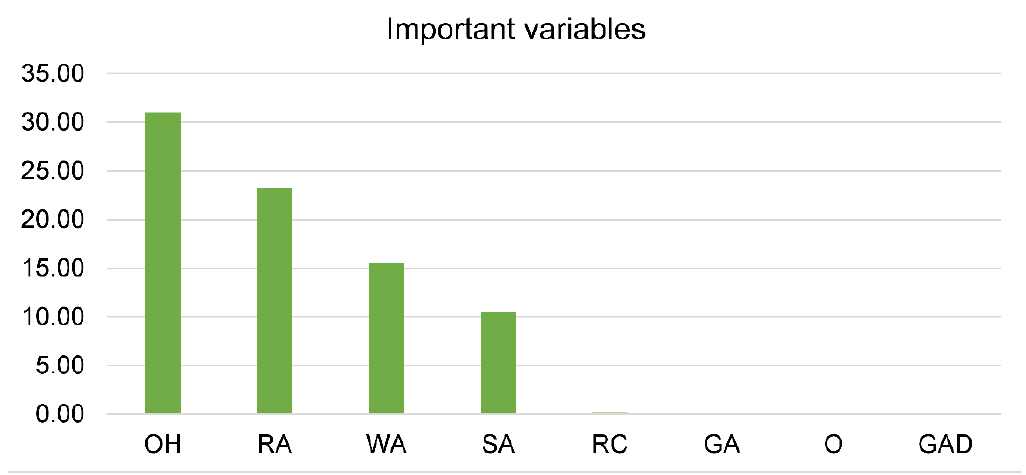
Figure 17. The importance of the input variables used in this study.